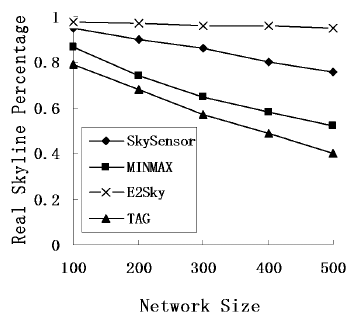
Figure 7. Real skyline percentage under different data and different network sizes.